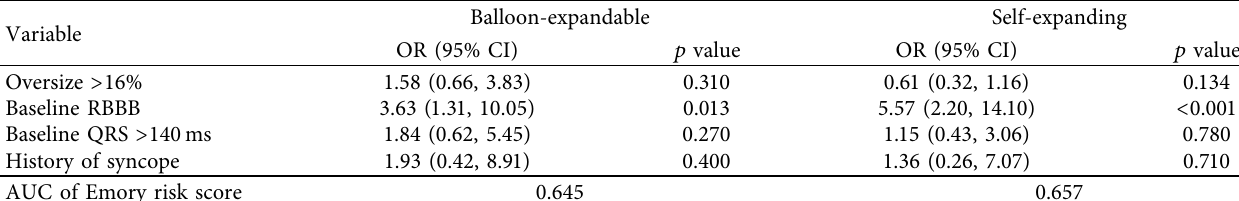
Table 2: Multivariable analysis of predictors of postoperative PPM rates, by valve type.